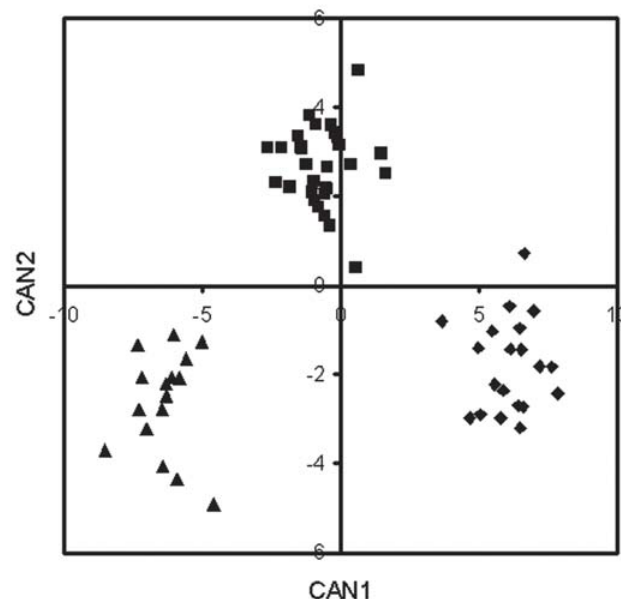
Fig. 6. Scatter plot resulting from the size-free canonical variate analysis of P. britskii (squares), P. ortmanni (diamonds) and P. maculatus